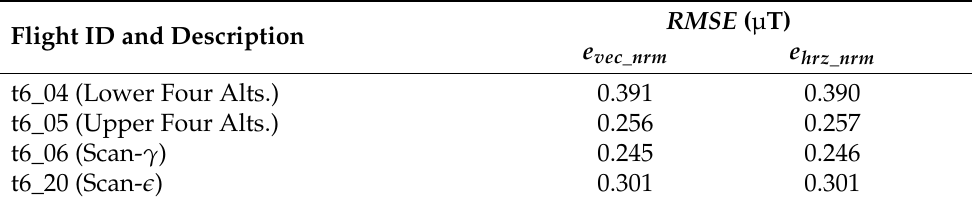
Table 4. Norm ( nrm ) GPR versus vector ( vec ) GPR on estimating norm of magnetic field. Flight ID and